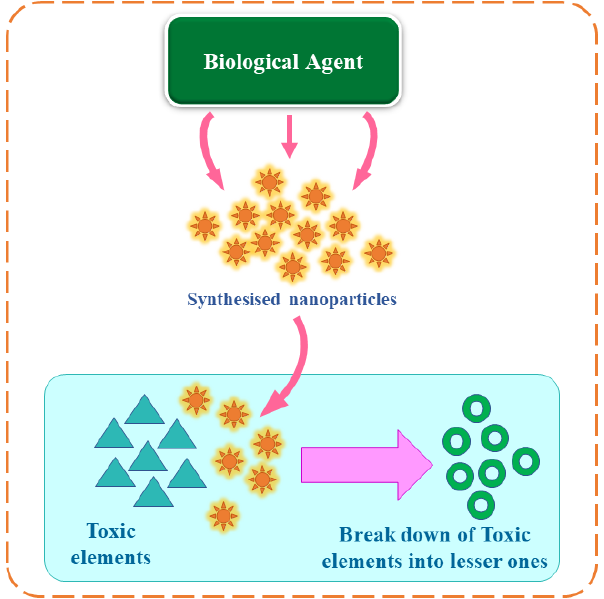
Figure 6. Concept of bioremediation using green nanoparticles.